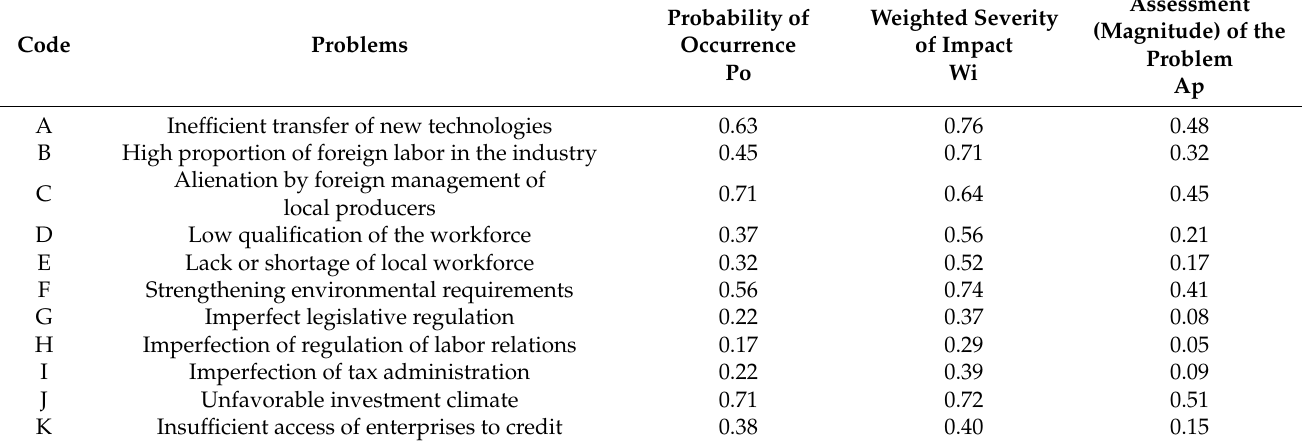
Table 1. Assessment of the problems of the oil and gas industry of Kazakhstan.